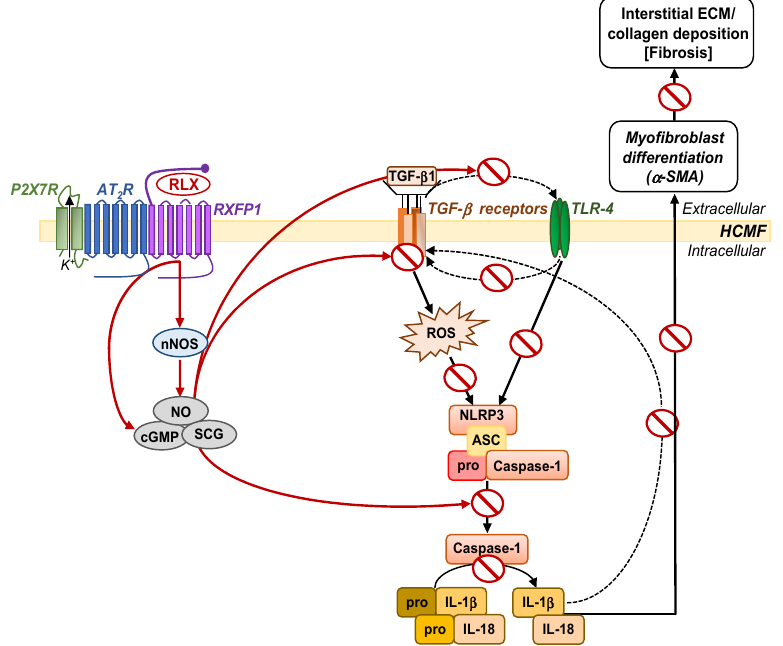
Figure 7. A schematic illustration summarizing the main findings of this study in relation to those of previously published findings on the RLX signal transduction of myofibroblasts [29–31,34,35]. It is now proposed that RLX signals through its cognate receptor, RXFP1, the AT 2 R and P2X7R on HCMFs (when all three receptors are appropriately expressed) as well as a RXFP1-nNOS-(NO-sGC- cGMP)-mediated mechanism to disrupt the induction of the myofibroblast NLRP3 inflammasome at the level of the TLR-4 (and the TLR-4/TGF- β 1 axis [42]) and ROS. This study confirmed that RLX can also directly inhibit the myofibroblast NLRP3 inflammasome (at the level of caspase-1) to me- diate its anti-fibrotic actions in HCMFs and the LV of ISO-injured mice. This in turn would result in the RLX-induced inhibition of the pro-fibrotic TGF- β 1/IL-1 β and TGF- β 1/IL-18 interactions on my- ofibroblast differentiation and myofibroblast-mediated ECM/collagen synthesis and deposition (fi- brosis). These results, firstly, confirm the direct involvement of RXFP1 in the NLRP3 inflam- masome-inhibitory effects of RLX. Whilst it was previously only demonstrated that the HCMFs used in this study expressed RXFP1 [34], the current study further validated that RXFP1 blockade (with the B-R13/17K H2 compound) was able to annul the myofibroblast NLRP3 inflammasome-inhibitory effects of RLX (from the level of TLR-4 to pro-IL-1 β and pro-IL-18). Secondly, the results obtained align with growing evidence which has pointed out that RLX-RXFP1 signalling is able to interact (or potentially undergo crosstalk) with other receptors to mediate the therapeutic effects of RLX, including the AT 2 R [27,28,33], Notch-1 [32], glucocorticoid receptor [43,44] and PPAR ϒ [45,46]. Furthermore, the results obtained from the in vitro studies conducted confirmed that RXFP1-AT 2 R crosstalk played a central role in facilitating the therapeutic effects of RLX [27,28,33], which now appear to include its ability to inhibit myofibroblast NLRP3 inflammasome activity (Figure 7). What this study has additionally provided is the novel finding that RLX appears to also modulate the P2X7R on HCMFs and, within the LV of ISO-induced mice with cardi- omyopathy, to inhibit NLRP3 inflammasome activity. This is based on the demonstration that the inhibitory effects of RLX (via RXFP1) on measures of NLRP3 inflammasome prim- ing and activity were annulled by the pharmacological blockade of P2X7R (using A-